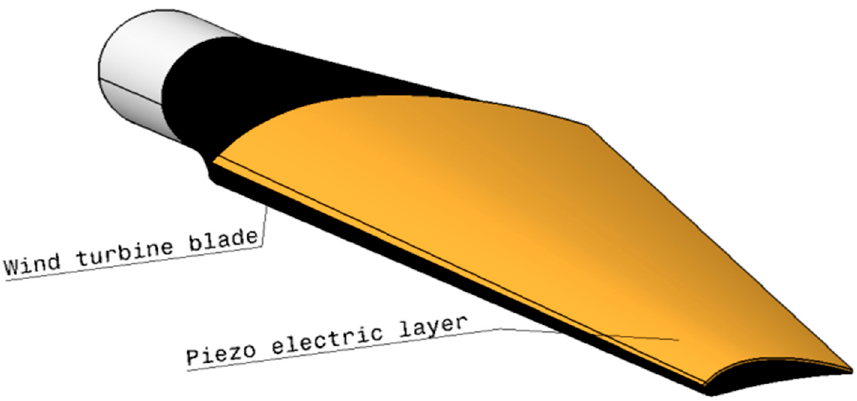
Figure 33. Power (P 0 ) in W with 25% attachment coverage—airplane wing.